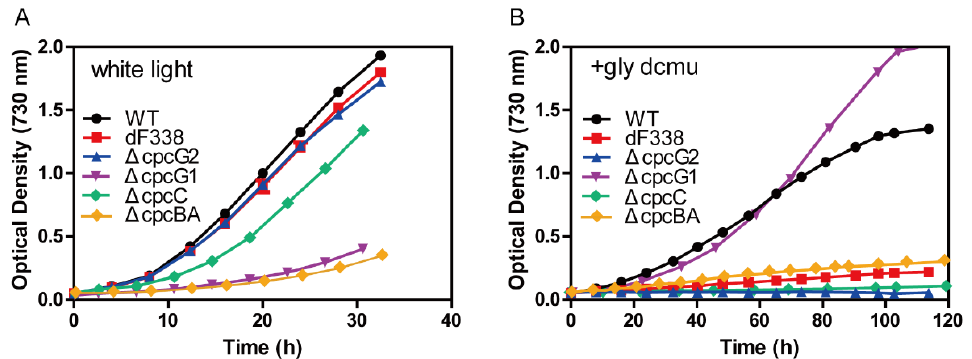
Figure 3. Growth curves of the wild-type (WT) and the mutant strains. ( A ) Photoautotrophic growth curves of WT and the mutant strains were obtained under white light condition provided with cool white fluorescent light at 200 μmol photons m − 2 s − 2 . ( B ) Photoheterotrophic growth curves of WT and the mutant strains in the presence of glycerol (10 mM) and DCMU (10 μM) under a light intensity of 50 μmol photons m − 2 s − 2 . Colors of the curves are as follows: black for WT; red for dF338; blue for ΔcpcG2; purple for ΔcpcG1; green for ΔcpcC; and yellow for ΔcpcBA.